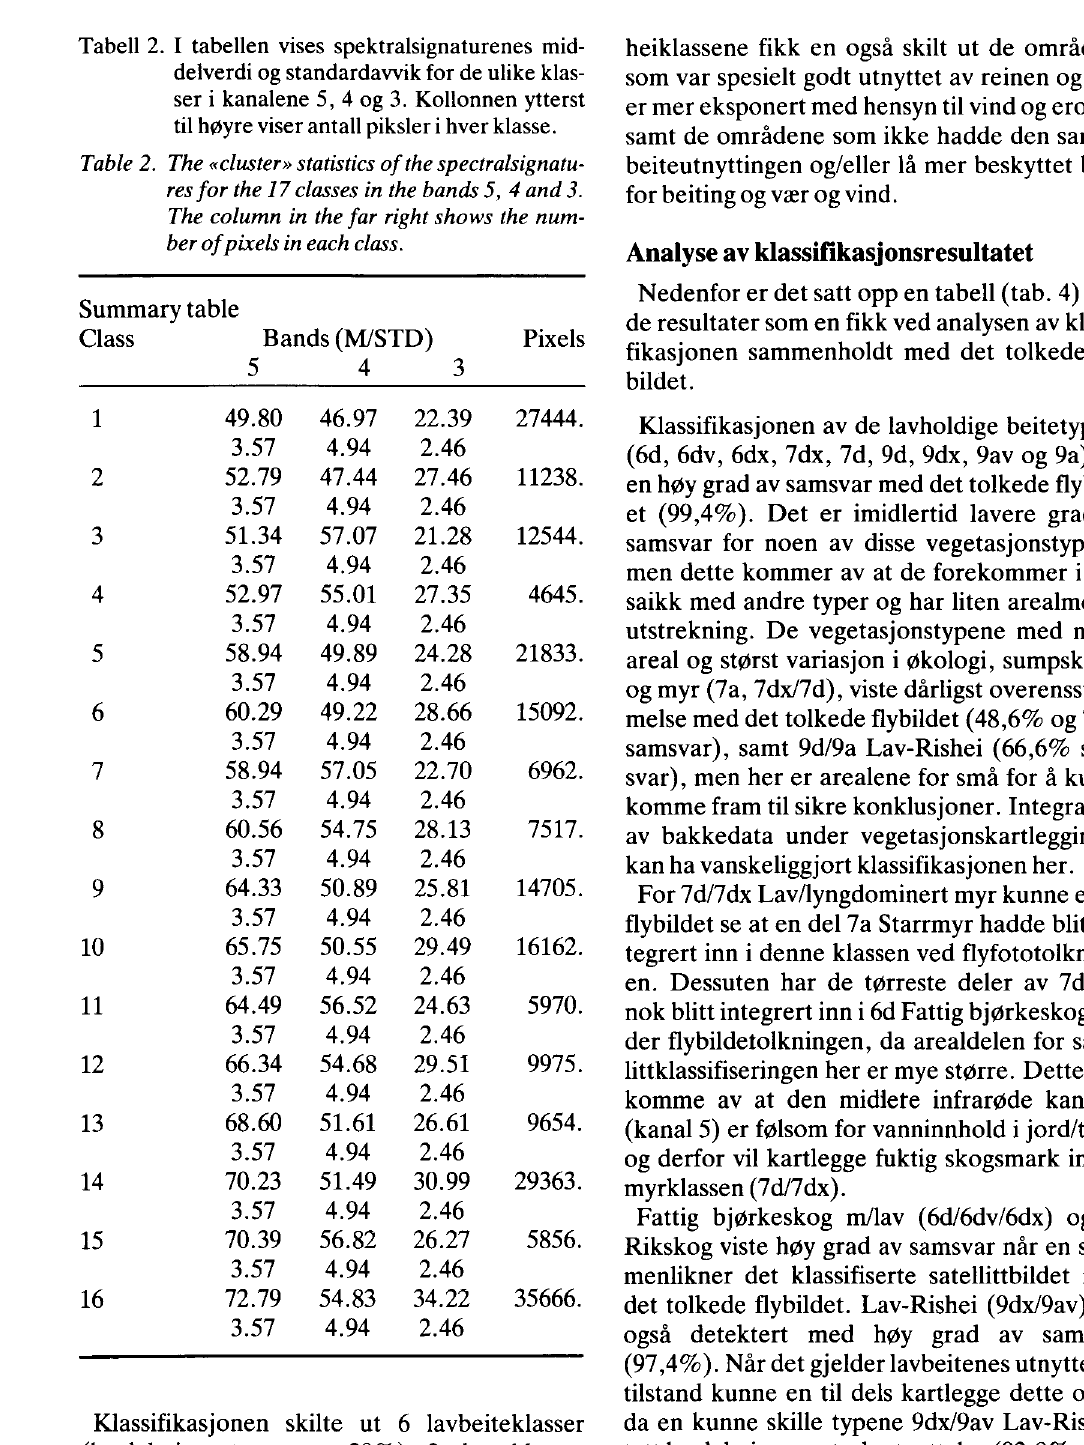
Tabell 2. I tabellen vises spektralsignaturenes mid delverdi og standardavvik for de ulike klas ser i kanalene 5, 4 og 3. Kollonnen ytterst Table 2. The «duster» statistics of the spectralsignatu- res for the 17 classes in the bands 5, 4 and 3. The column in the far right shows the num ber of pixels in each class.